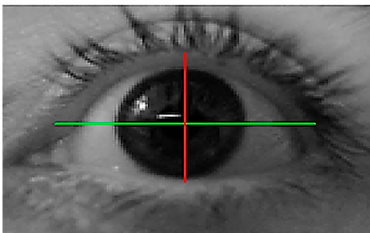
Figure 2. Robot control input parameters range (the X-axis regulate steering and the Y-axis regulates speed).